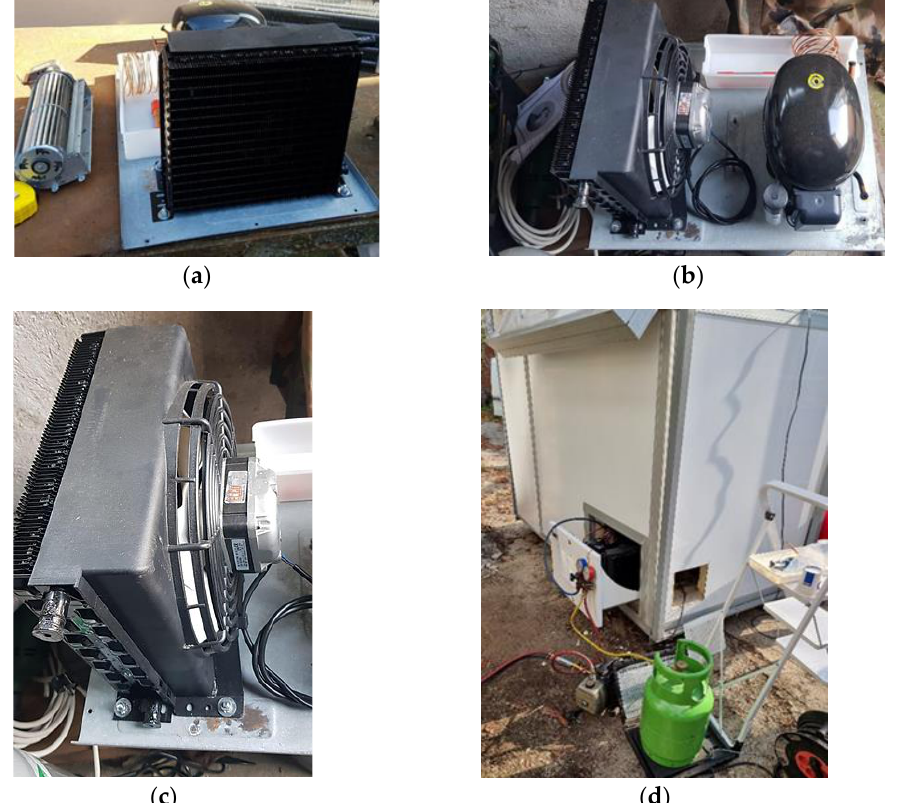
Figure 6. ( a , b ). Refrigeration plant general view; ( c ) condensing unit; ( d ) R290 charging process . Table 4. Refrigeration system components .